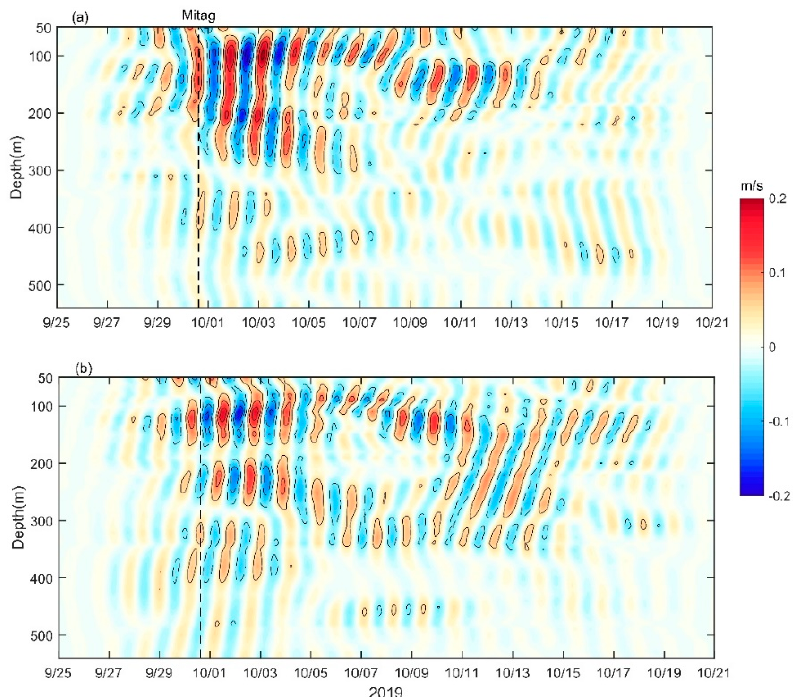
Figure 5. Vertical profiles of zonal ( a ) and meridional ( b ) near-inertial currents. Solid (dashed) contours, starting at 0.05 ( − 0.05) m/s, denote positive (negative) values. Intervals between adjacent contours are 0.05 m/s. Vertical black dashed lines indicate the time of closest approach to the mooring by the center of typhoon Mitag.